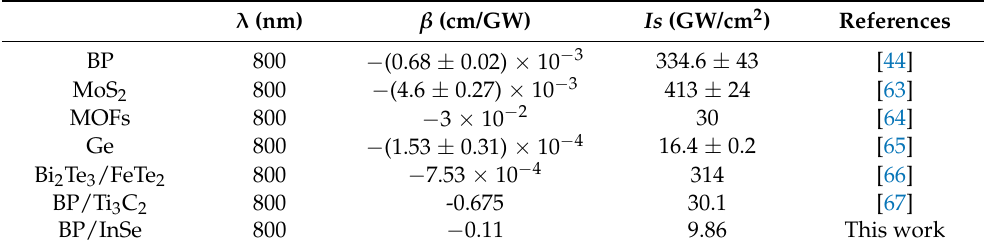
Table 2. Summary of β and I s values for various different NLO